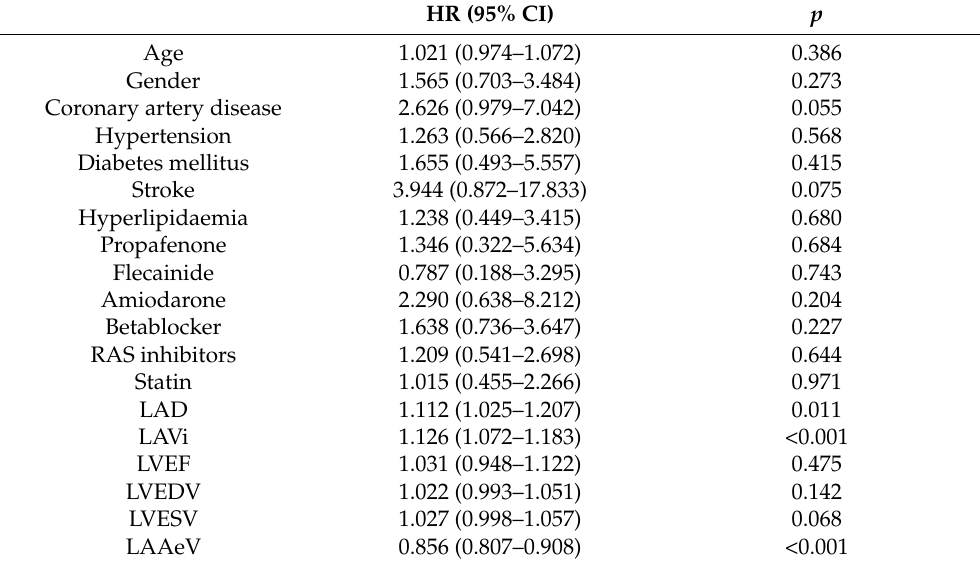
Table 3. Univariate analysis for AF recurrence.